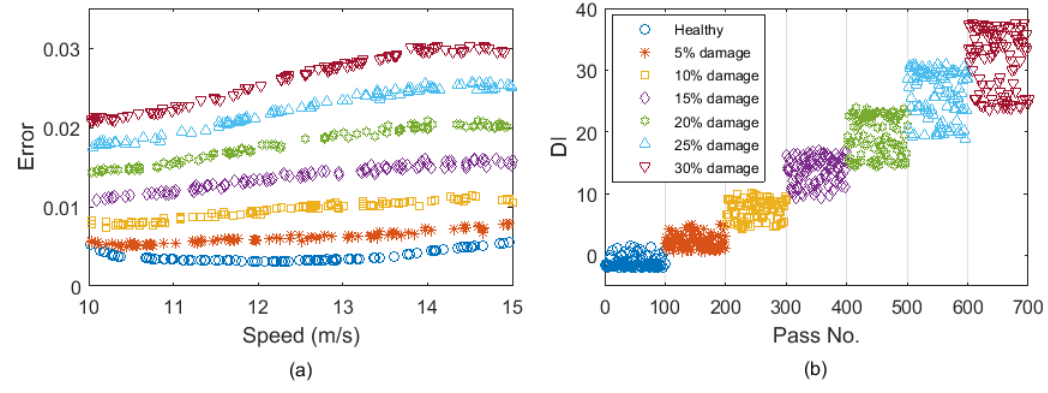
Figure 7. ( a ) The prediction errors and ( b ) DI for the healthy and damaged cases (DI: damage indicator).